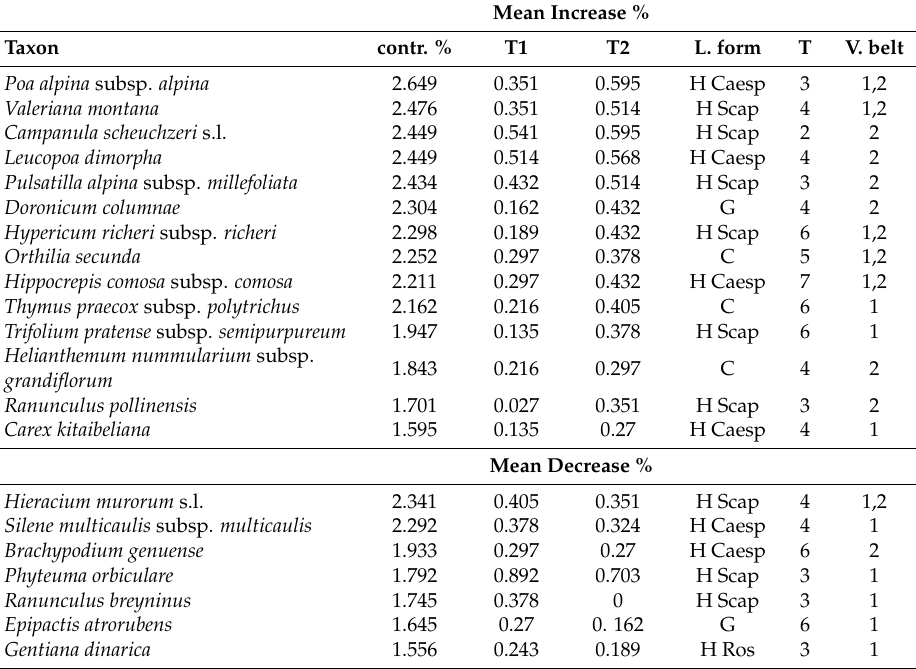
Table 1. The contribution of plant species (contr. %) to the observed differences between plant communities in the two time periods (T1: 1992 and T2: 2016/17) assessed by the similarity percentage procedure (SIMPER, [72]). For each taxon, the life forms (L. form: C: chamaephytes, G: geophytes and hemicryptophytes, H, subdivided into Hcaesp: caespitose, Hrept: reptant, Hros: rosulate and Hscap scapose), the Ellenberg ecological indicator values for temperature (T), and the vegetation belt where the species occur (V. belt: 1 = lower subalpine; 2 = upper subalpine) are also reported.